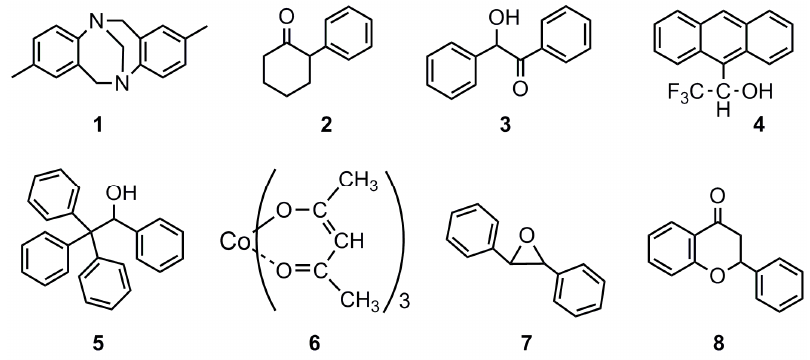
Figure 4. Racemates used for evaluation of CSPs by HPLC.